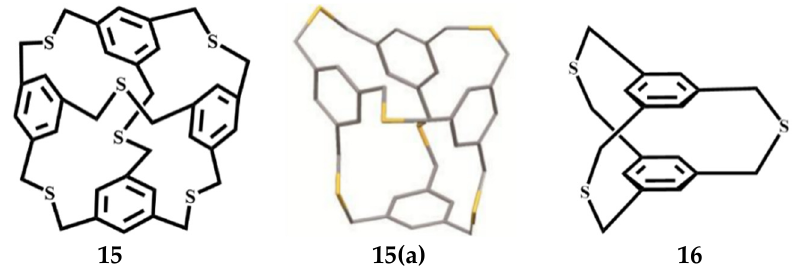
Figure 10. The conformation of C 36 H 36 S 6 15 and 2, 11, 20-trithia[3 3 ](1, 3, 5)cyclophane 16 . Mikio et al. studied the crystal structure of [3 6 ](1,2,3,4,5,6)CP with a series of complexes synthesized by TCNQ [58]. In the crystal structure of the [3 6 ](1,2,3,4,5,6)CP-TCNQ-benzene (1:1:1) complex 17 (Figure 11) at − 190 ◦ C, a TCNQ (acceptor) and a